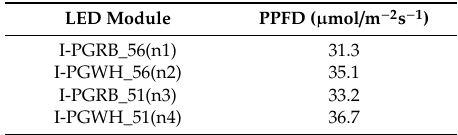
Table 3. Photosynthetic photon flux density (PPFD) measurement